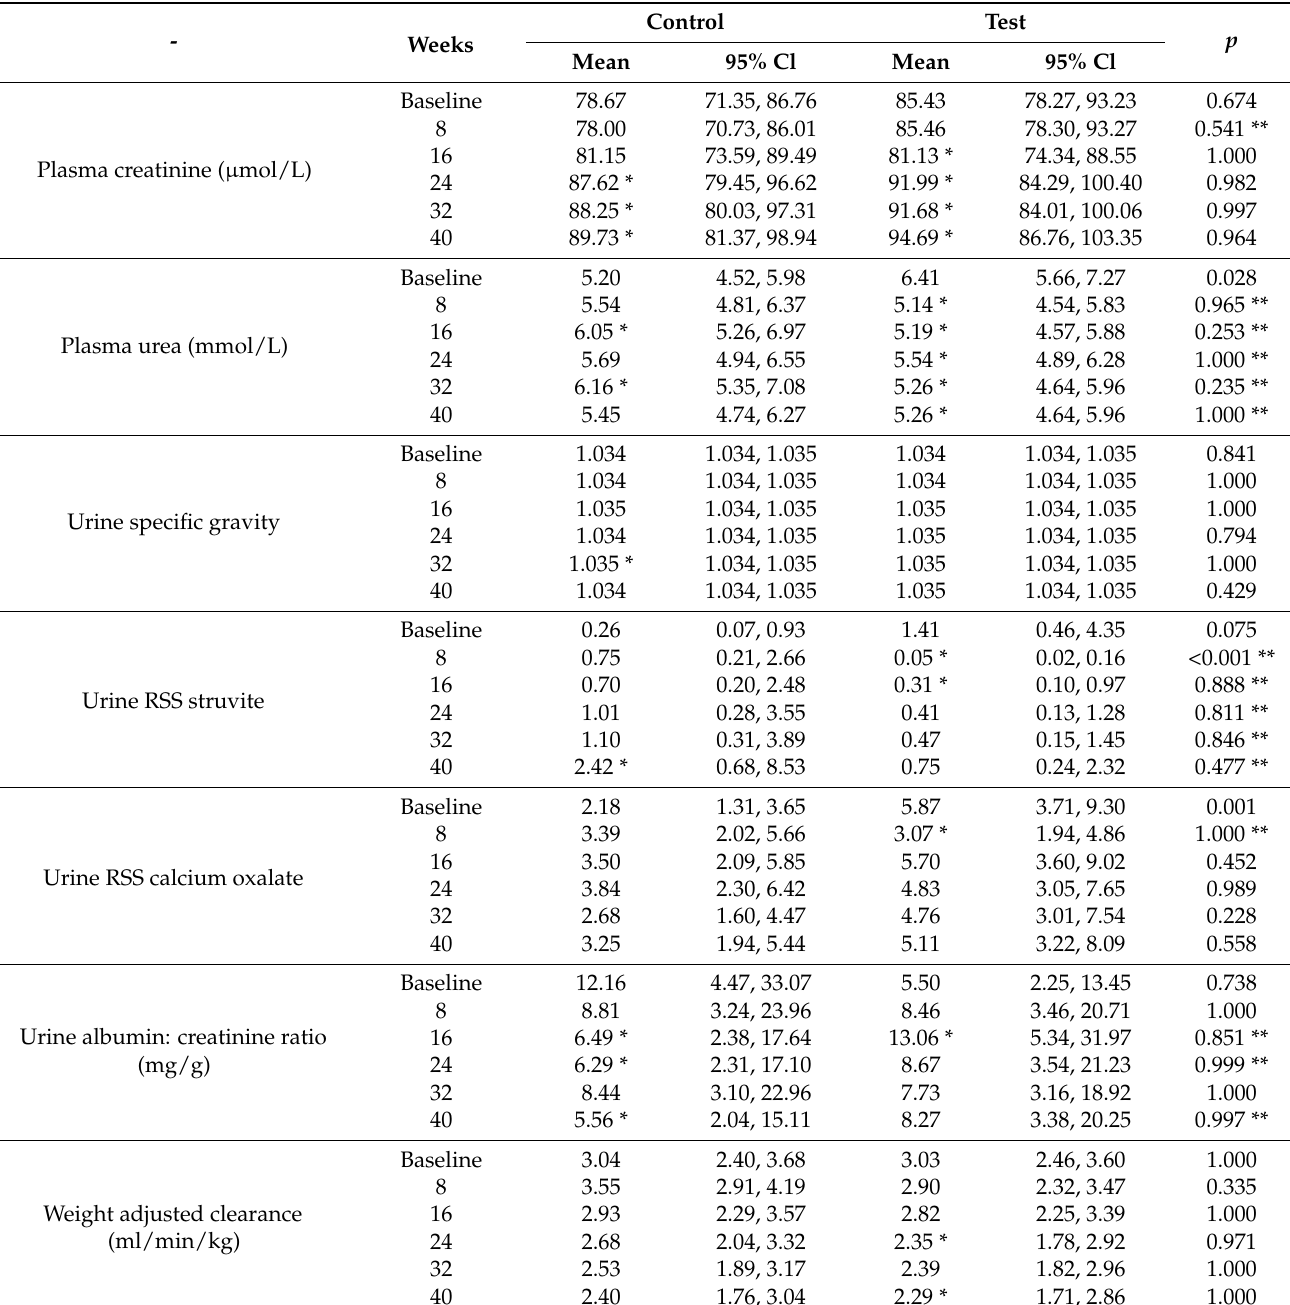
Table 4. Renal and urinary tract health measure values given as means and 95% confidence intervals (CI) for the control ( n = 8) and test ( n = 10) diet dog groups at baseline and at eight-week intervals. p -Values represent comparison between diet groups at the sample collection time